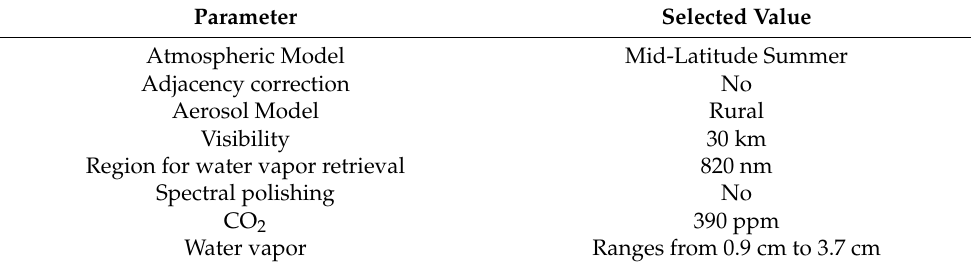
Figure 4. Process flow. Table 2. ATCOR parameters.